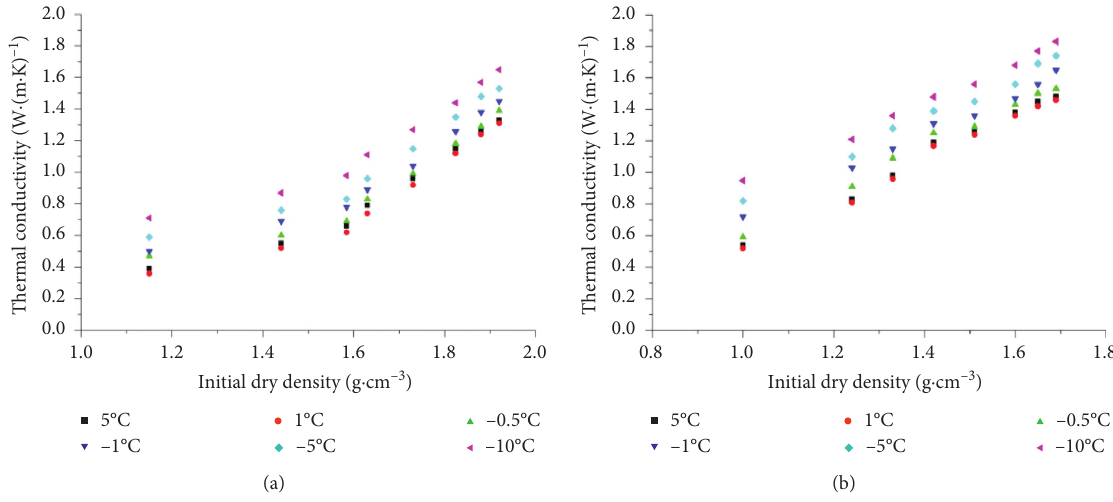
Figure 4: Variation of the thermal conductivity of the soil specimens with dry density. (a) w � 14%. (b) w � 20%. Table 3: Thermal conductivity of basic constituents of soils [12]. Basic constituents Water Ice Air Soil skeleton Thermal 0.465 2.21 0.024 1.2 ∼ conductivity/ ( W/ ( m · K ))